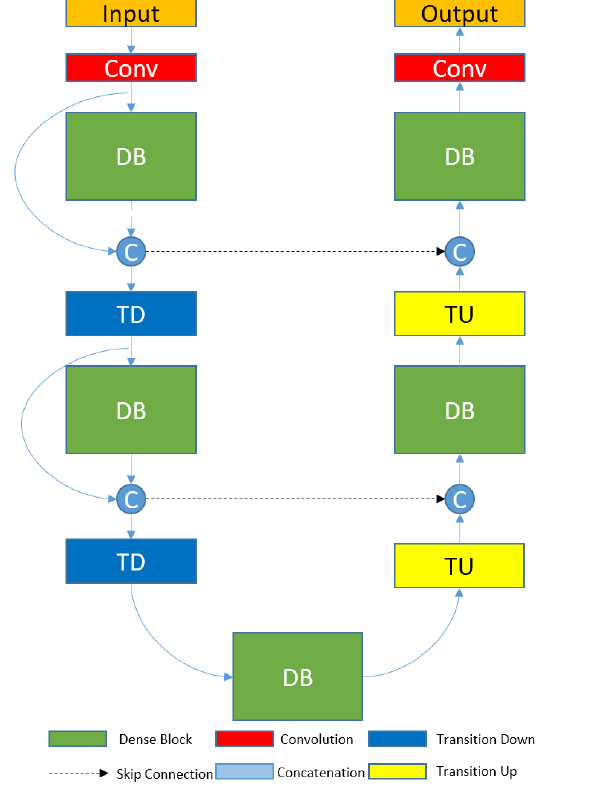
Figure. 4 The diagram of our proposed